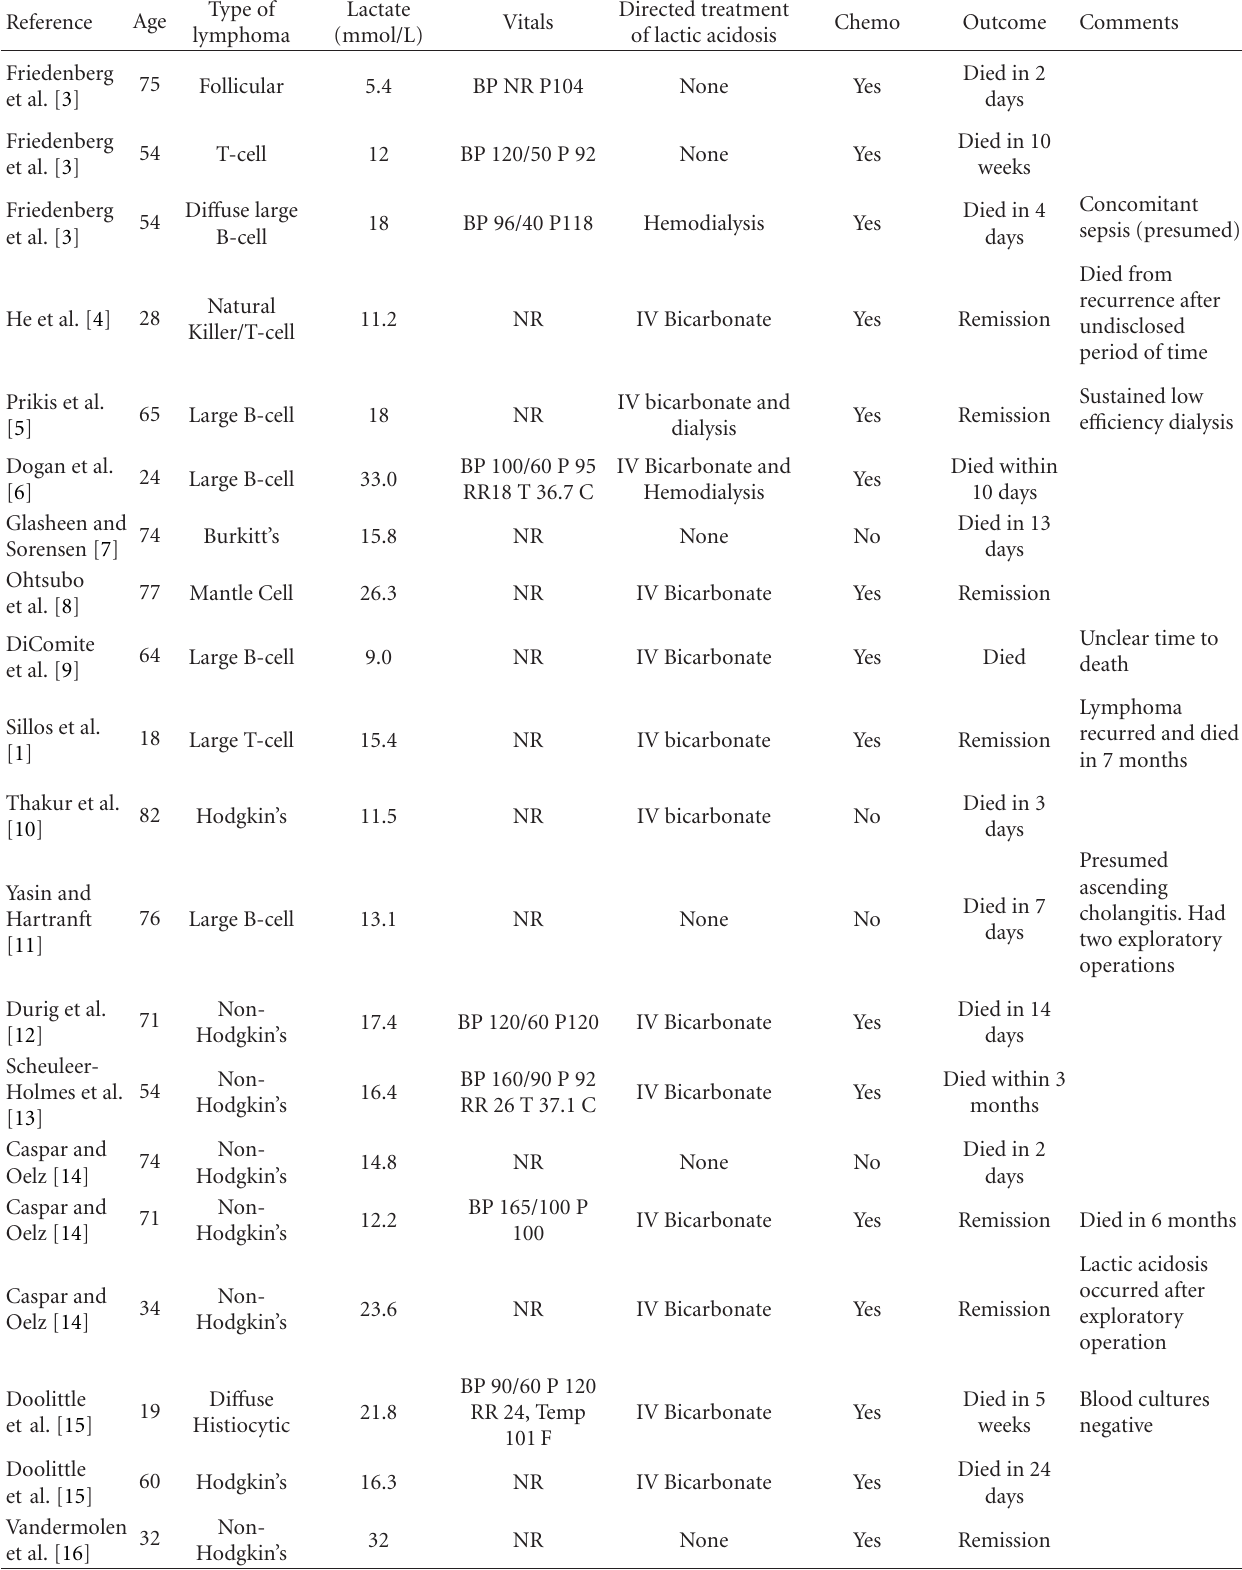
Table 1: Summary of all reported cases of lactic acidosis associated with lymphoma. (NR: normal range; BP: blood pressure; RR: respiratory rate; P: pulse; T: